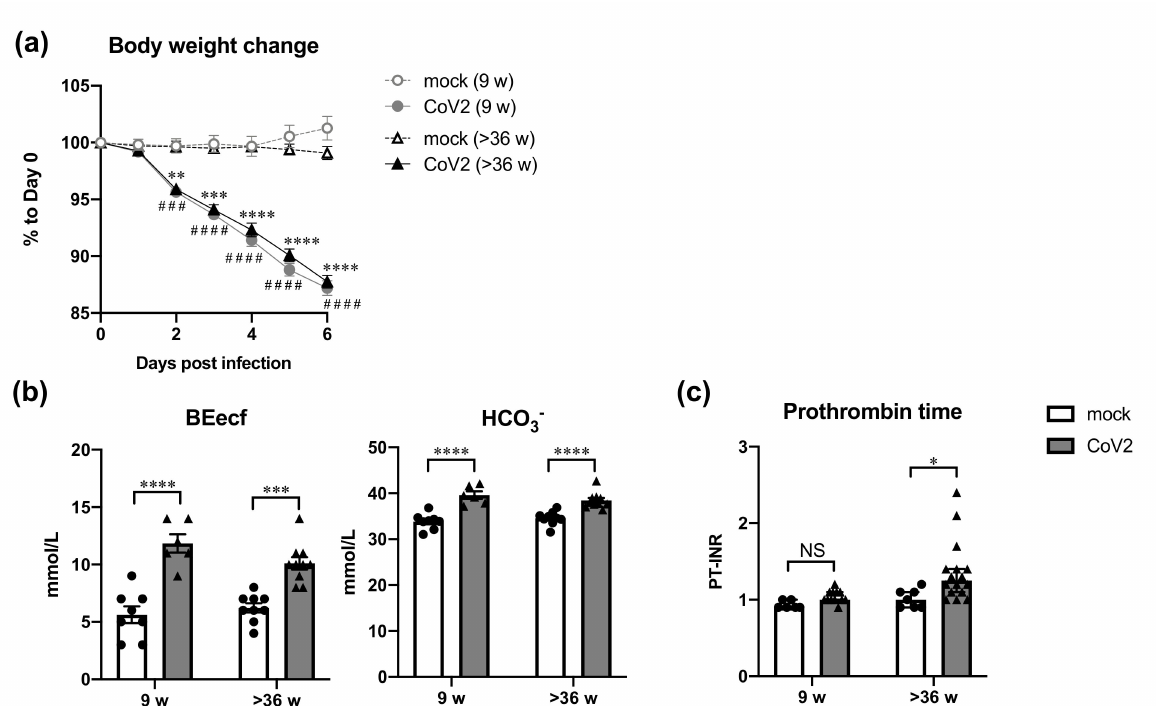
Figure 1. Changes of body weight and blood parameters in young and aged hamsters infected with SARS-CoV-2. Young (9 w) and aged (>36 w) hamsters were intranasally inoculated with PBS control (mock) or PBS containing SARS-CoV-2 virus (CoV2). Body weight was monitored daily until 6 days post infection (dpi) ( a ), and the hamsters were euthanized at 6 dpi for the collection of blood samples for measurement of acid-base status parameters BEecf and HCO 3 − ( b ), and prothrombin time ( c ). ( a ) Symbols indicate the mean body weight ± SEM represented as a percentage of the original weight [mock (9 w), n = 7; CoV2 (9 w), n = 12; mock (>36 w), n = 7; CoV2 (>36 w), n = 17]. Circles and triangles indicate data from young and aged hamsters, respectively. Open and closed symbols indicate PBS control and virus-infected hamsters, respectively. ### p < 0.001, #### p < 0.0001 (young); ** p < 0.01, *** p < 0.001, **** p < 0.0001 (aged); two-way ANOVA with Tukey’s multiple comparison test. No significant difference was detected between young and aged hamsters at each time point. ( b , c ) White and gray bars indicate data from mock and CoV2-infected hamsters, respectively. Each dot indicates data from each individual. Bars indicate the mean ± SEM [( b ) mock (9 w), n = 8; CoV2 (9 w), n = 6; mock (>36 w), n = 9; CoV2 (>36 w), n = 10] or the median ± interquartile; ( c ) 9 w-mock, n = 6; 9 w-CoV2, n = 12; >36 w-mock, n = 7; >36 w-CoV2, n = 16]. * p < 0.05, *** p < 0.001, **** p < 0.0001, two-way ANOVA with Sidak’s multiple comparison test. BEecf, base excess extracellular fluid; PT-INR, international normalized ratio of prothrombin time; NS,